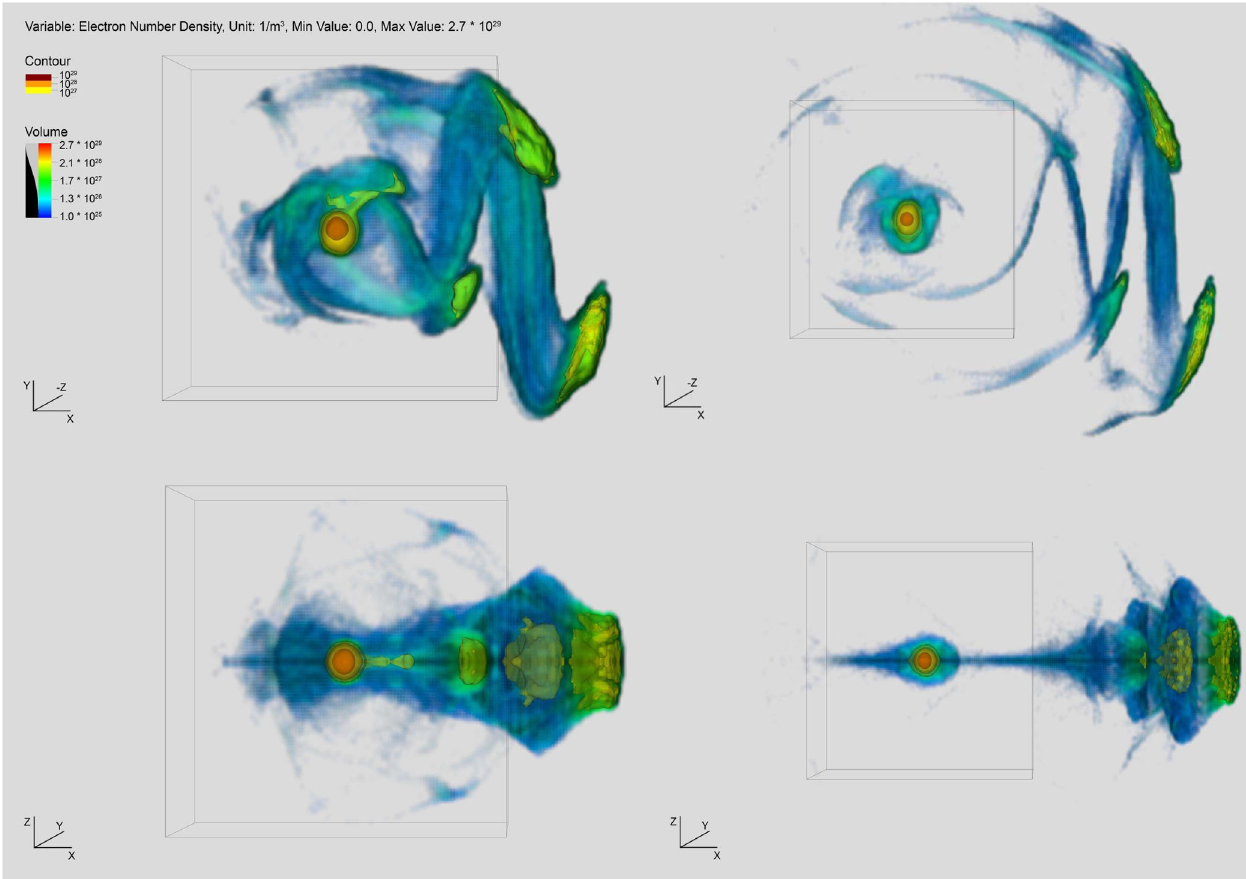
FIG. 2. Logarithmic plot of the electron number density for a 100 times overdense droplet with R ¼ 100 nm as it evolves in the field of a linearly polarized Gaussian laser pulse with I ¼ 10 20 W = cm 2 . The contoured regions represent the dense regions which can be identified as the proper nanobunches, at, respectively, t ¼ 10 fs (left) and 15 fs (right) after the start of the laser-droplet interaction. Two main perspectives are represented: xy-plane view (up) and xz-plane